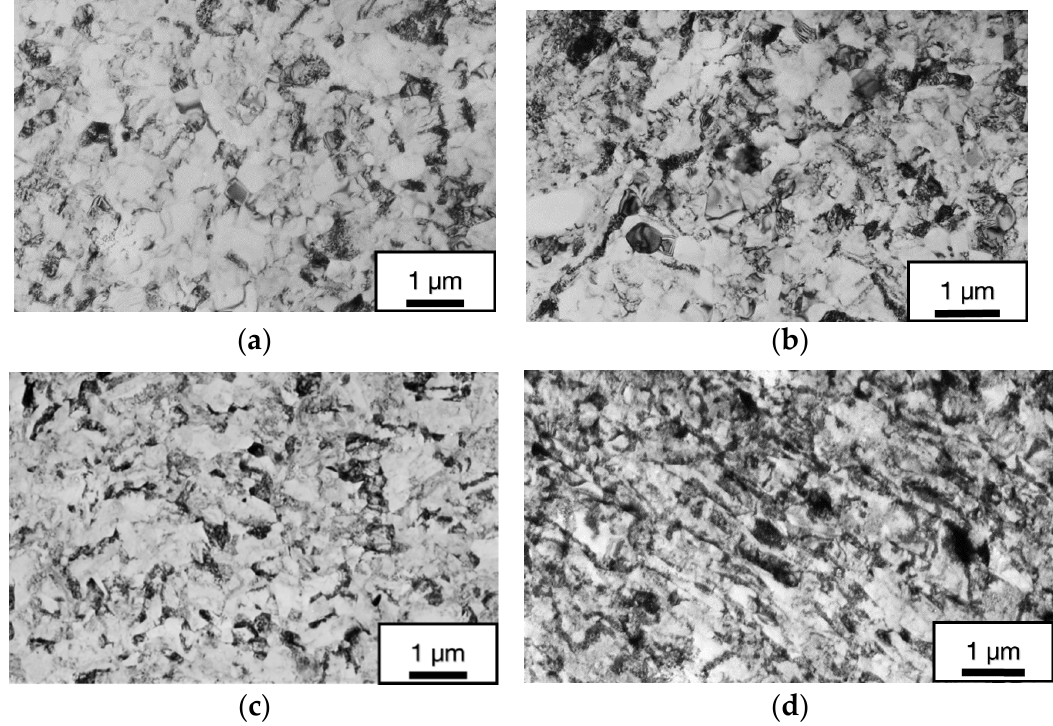
Figure 10. TEM micrographs of mechanically-worked titanium Grade 2: ( a ) after one Conform SPD pass, longitudinal cross-section, ( b ) after one Conform SPD pass, transverse cross-section, ( c ) after one Conform SPD pass and rotary swaging (1.6 true strain—80% area reduction), longitudinal cross-section, ( d ) after one Conform SPD pass and rotary swaging (1.6 true strain—80% area reduction), transverse